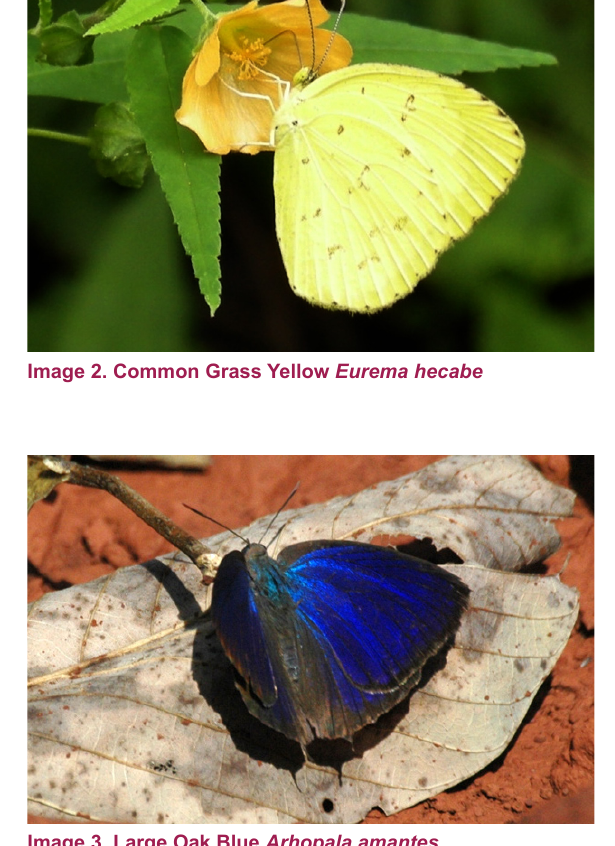
Image 3. Large Oak Blue Arhopala amantes